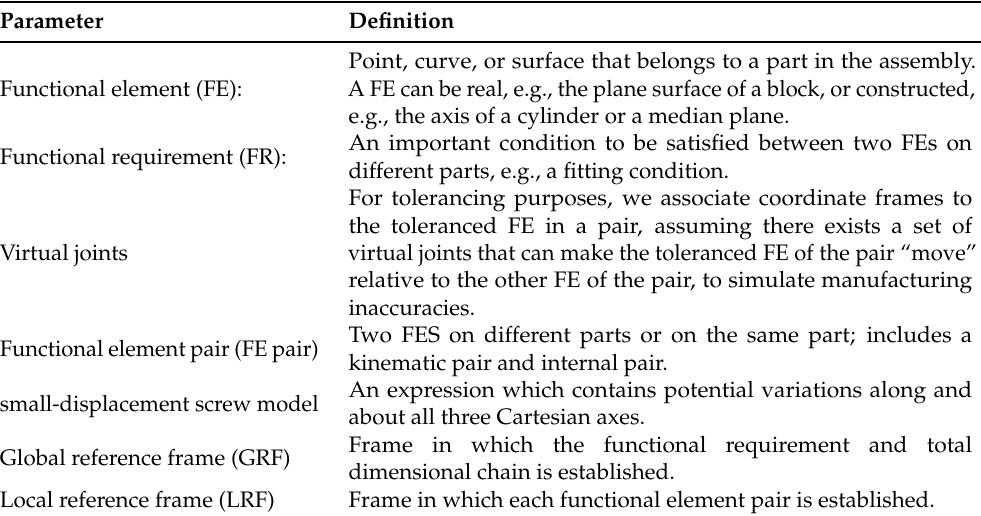
Table 1. The basic concepts of the Jacobian